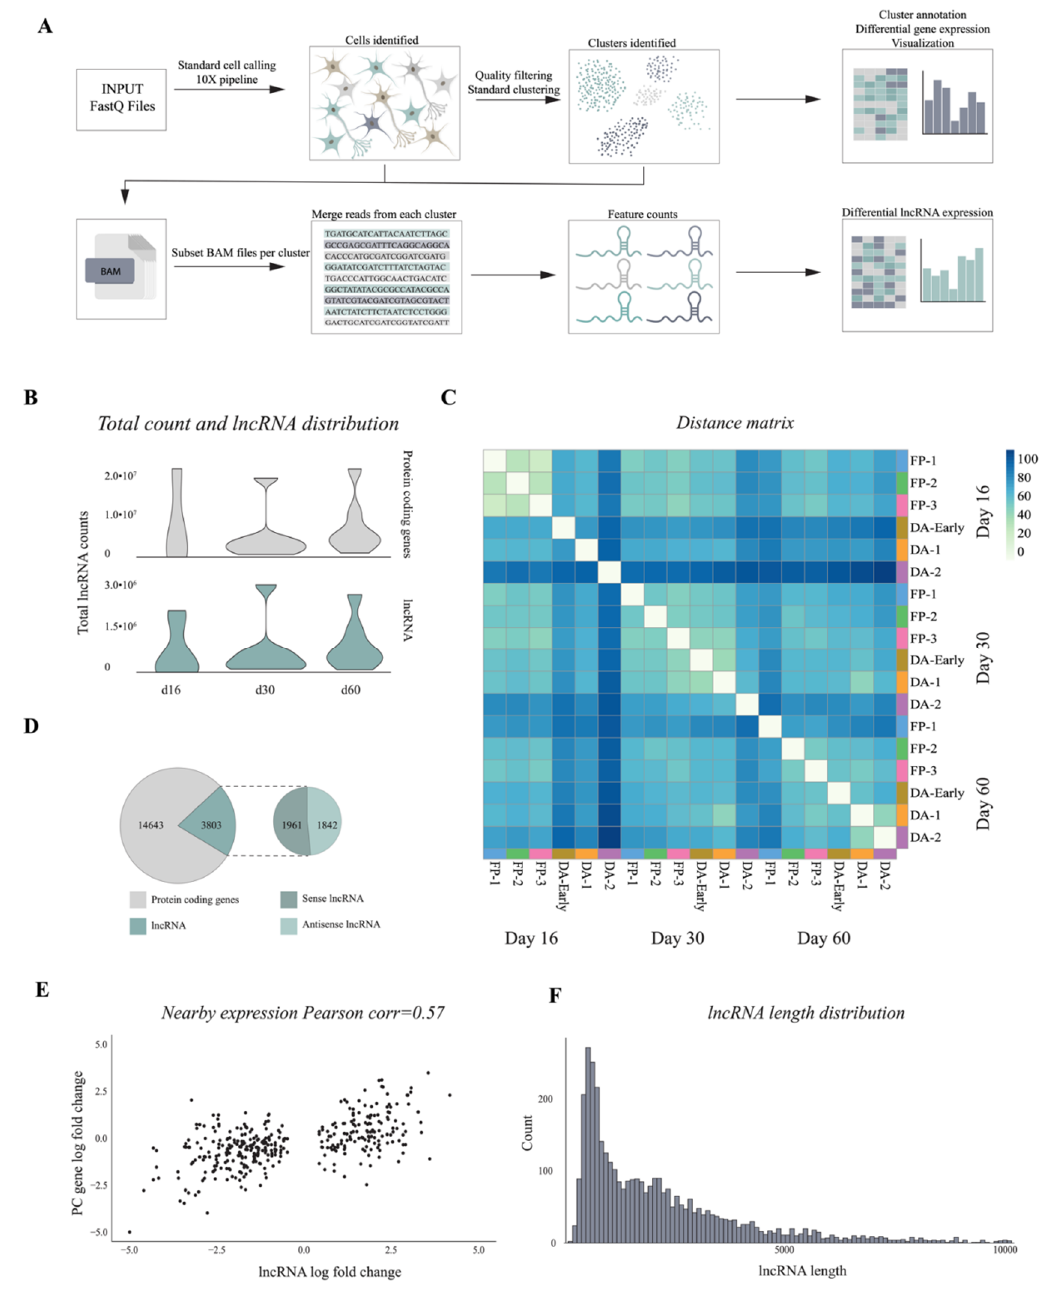
Figure 5. Bioinformatic pipeline detects lncRNAs from 10x Genomics single cell dataset ( A ) Schematic overview of pipeline designed for lncRNA quantification. ( B ) Count distribution of protein-coding genes and lncRNAs from each sample at three time points of hPSC DA neuron differentiation (day 16, 30, 60). ( C ) Heatmap of Euclidean distance across different cell types and time points (log2 normalized counts). ( D ) Number and distribution of protein-coding genes and lncRNAs expressed (baseMean >1), strand (sense “+”, antisense “ − ”). ( E ) Pearson correlation of change in expression of protein-coding genes and lncRNAs ( ± 5Kb, p adj < 0.01). The x-axis shows the log fold change of the lncRNA and the y-axis the log fold change of the overlapping protein-coding gene. ( F ) Length distribution of expressed lncRNAs